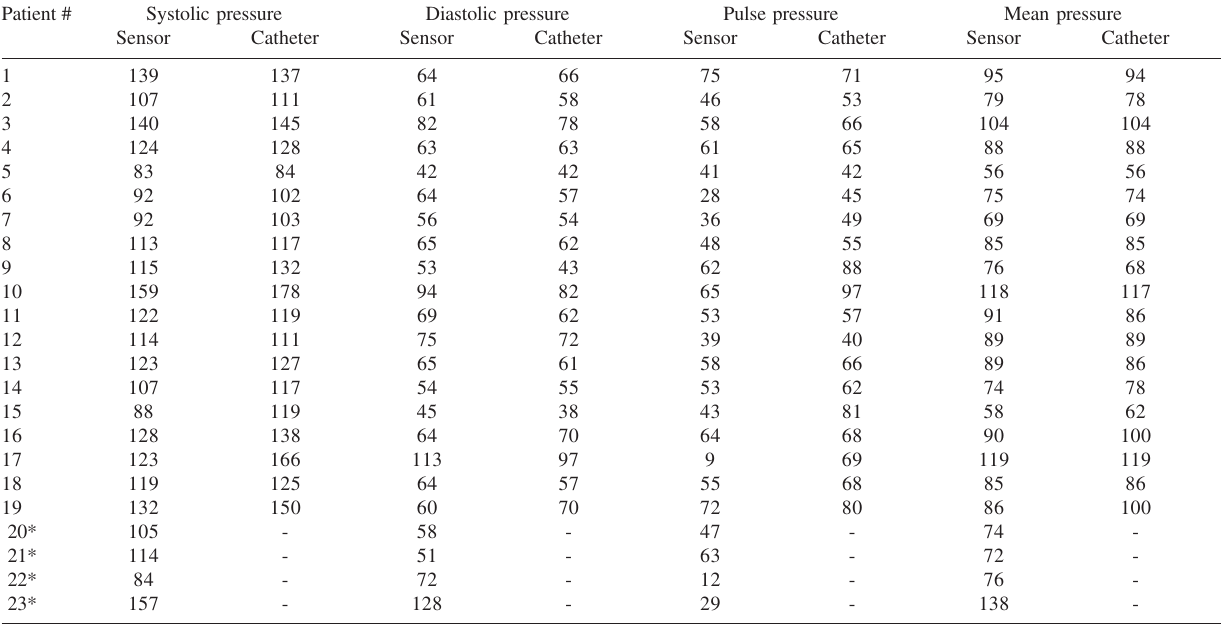
Table 2 - Intrasac pressure measurements for Reading 1